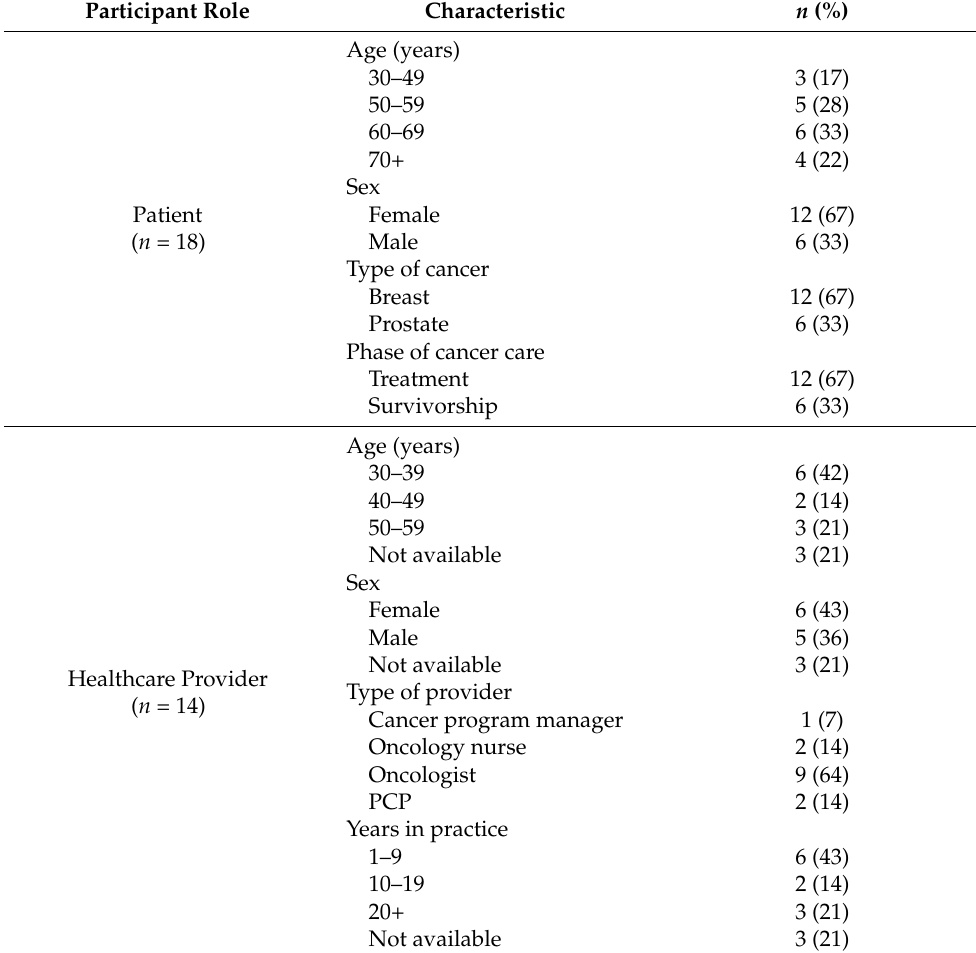
Table 2. Participant